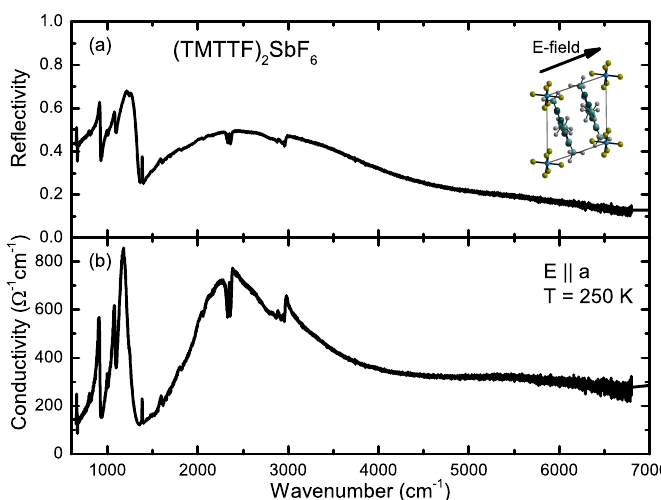
Figure 3. Frequency-dependent optical reflectivity ( a ) and conductivity ( b ) of (TMTTF) 2 SbF 6 along the crystallographic a direction measured at T = 250 K.